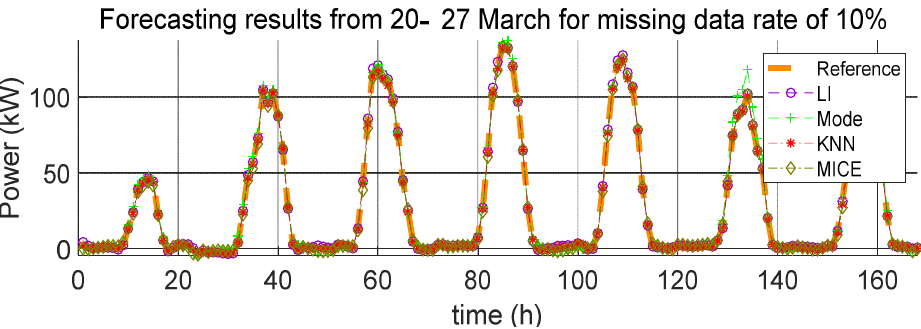
Figure 6. Forecasting results from 20 – 27 January for various missing data rates (10%, 15%, and 20%).